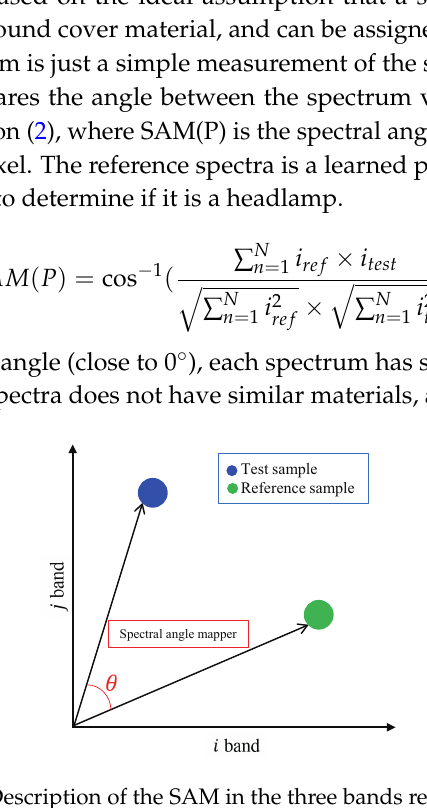
Figure 6. Description of the SAM in the three bands reference